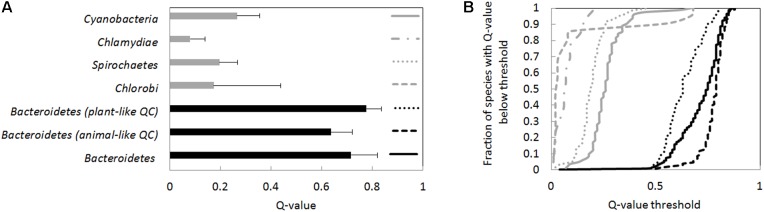
Q-values averages and Q-value distributions for different groups of bacteria. The Q-value was determined separately for every species in the groups. (A) Average Q-values for the species groups (species are given equal weight in the average), and the standard deviation of Q-values. Bacteroidetes have significantly higher Q-values than Chlorobi, Spirochoaetes, Chlamydiae, or cyanobacteria (p < 1E-6 for comparisons of Bacteroidetes against any of the other species groups according to the Wilcoxon rank sum test). (B) Cumulative Q-value distributions. For identification of species groups, refer to the symbols in the right panel (near Q-value 1). The Q-values for Bacteroidetes species are higher than for the other species groups also judging from cumulative distributions (p < 1E-6 according to the Kolmogorov–Smirnov test). Species were classified as having an animal- or plant-type QC according to BLASTP searches using the human and A. thaliana QC.